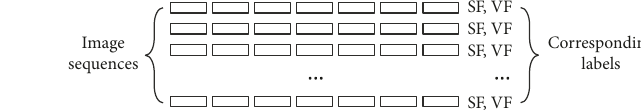
Figure 13: The enlarged dataset.